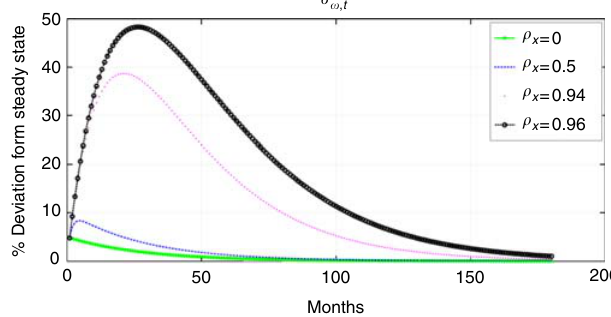
Figure 7. Response of uncertainty, σ ω , for different values of the persistence parameter ρ